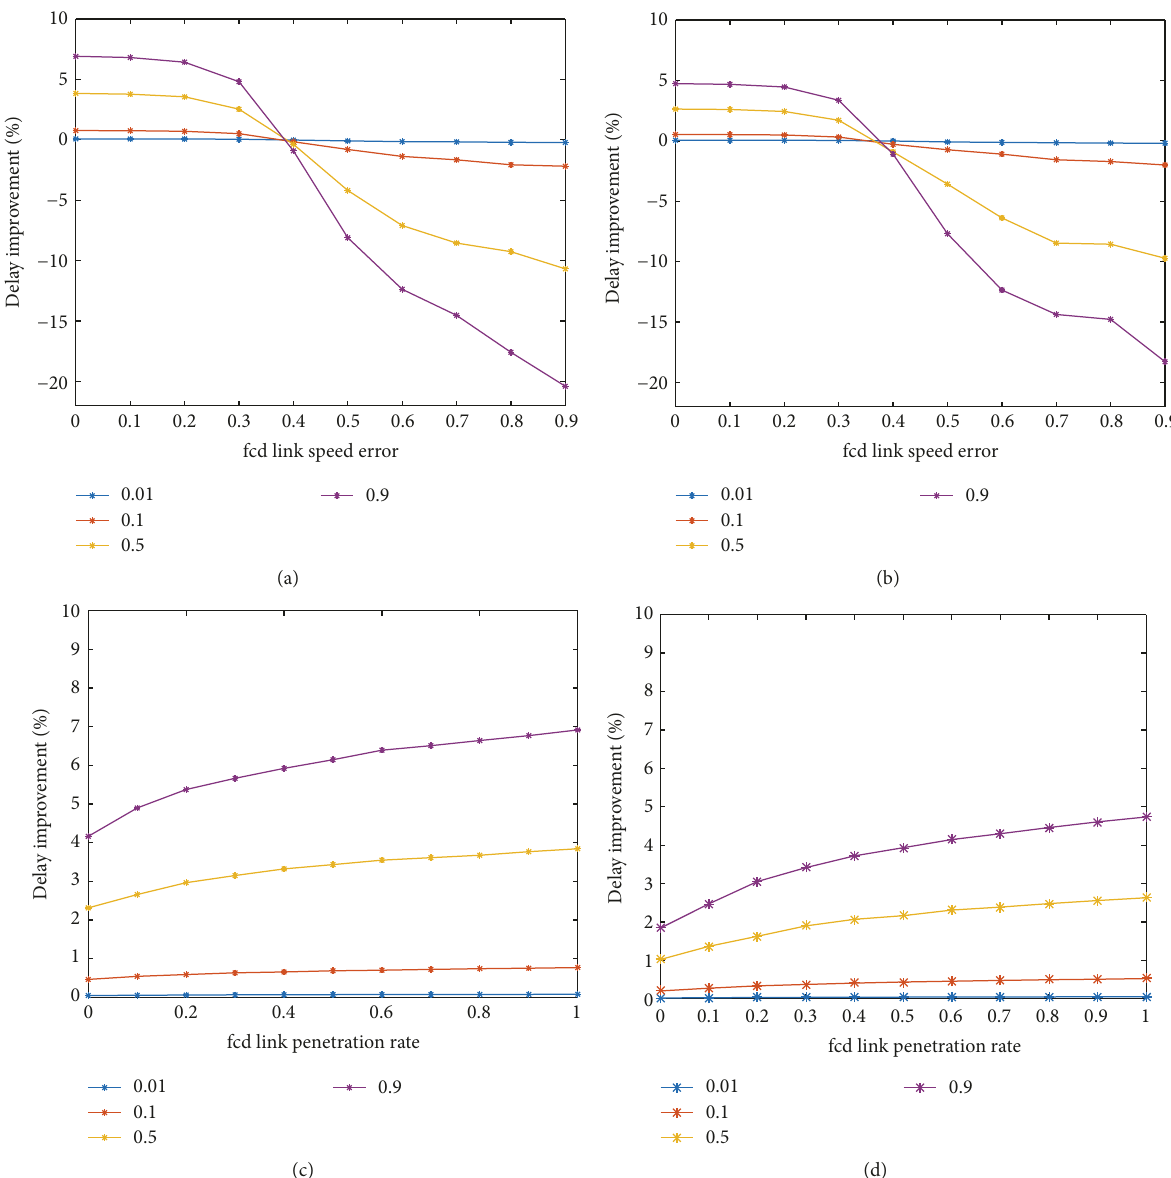
Figure 13: Delay improvement for 28 January 2016 (average day) as percentage with regard to the normal delay: variation in speed accuracy with best route advice (a), variation in speed accuracy with top 3-route advice (b), variation in link speed availability with best route advice (c), and variation in link speed availability with top 3-route advice